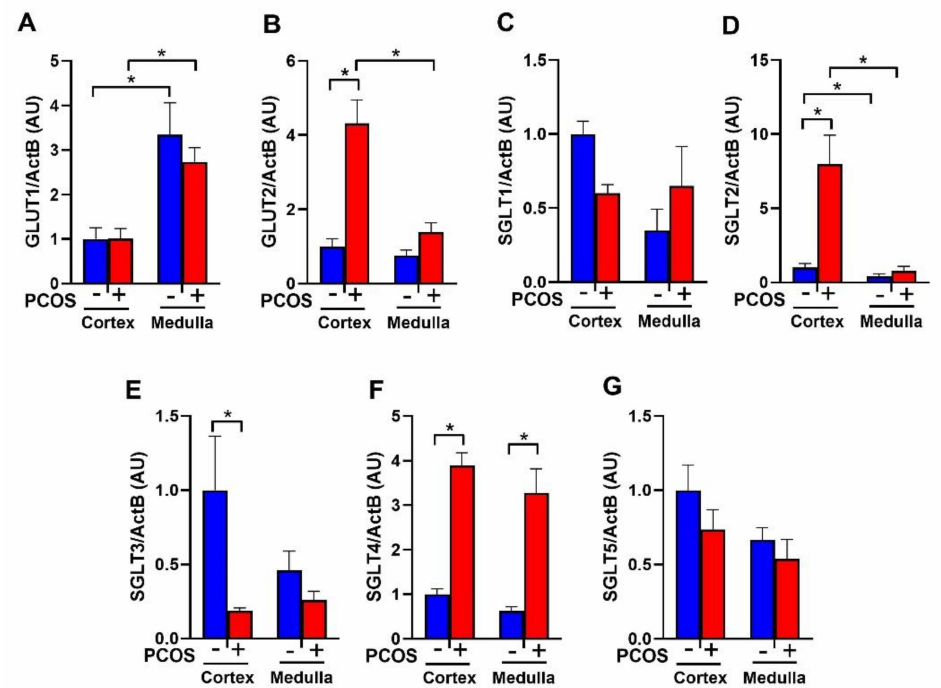
Figure 1. Renal glucose transporters mRNA expression in polycystic Ovary Syndrome (PCOS). Renal cortical and medullar mRNA expression of ( A ) GLUT1, ( B ) GLUT2, ( C ) SGLT1, ( D ) SGLT2, ( E ) SGLT3, ( F ) SGLT4, and ( G ) SGLT5 after 90 days of dihydrotestosterone (DHT) treatment. Data are expressed as mean ± SEM. Data were analyzed by two-way ANOVA followed by Tukey post-hoc tests. Significant interaction was only observed for SGLT2 and GLUT2. * p < 0.05. n = 6–8 per group. PCOS: Polycystic Ovary